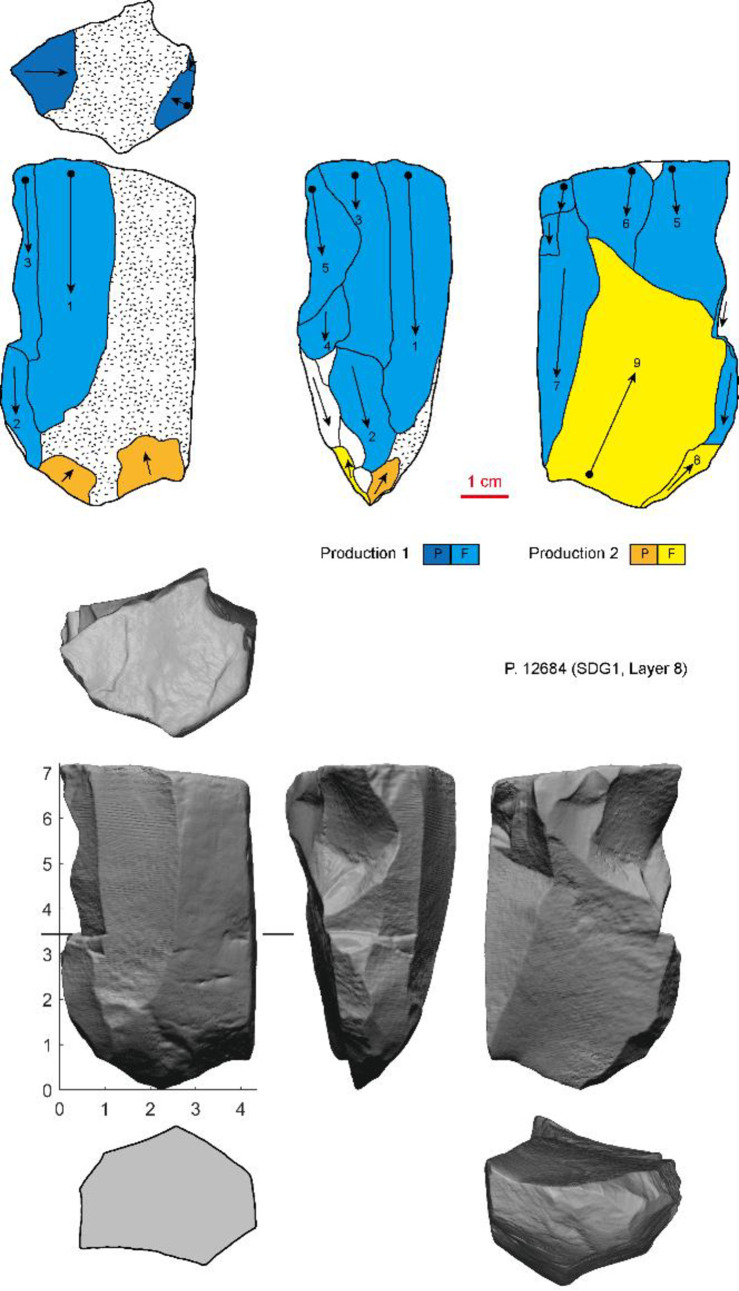
Examples of cores combing both Levallois-unidirectional/bidirectional and prismatic/subprismatic exploitation (different series of production are indicated by colors.P: Platform; F: Flaking surface).